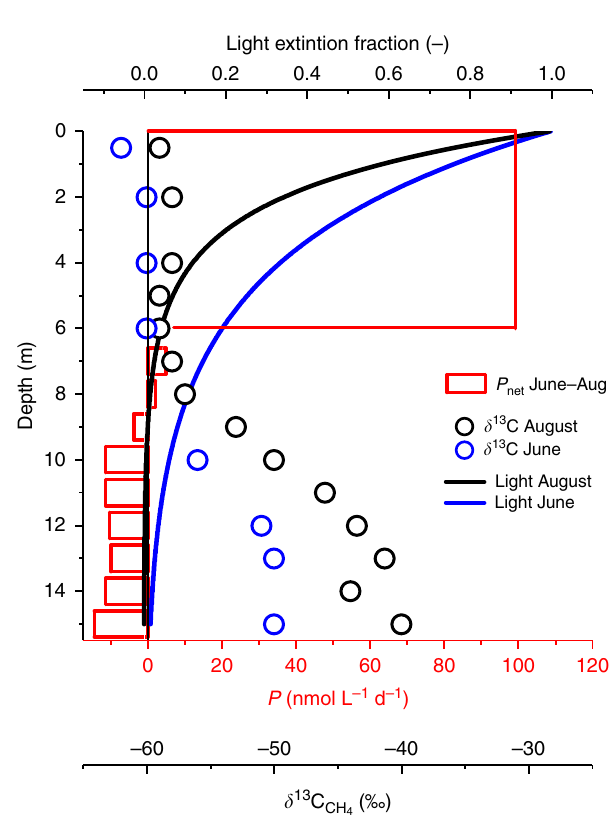
Fig. 7 Linking water column CH 4 production oxidation and light extinction. Net CH 4 production in the top 5 m as derived from mass balance (Eq.